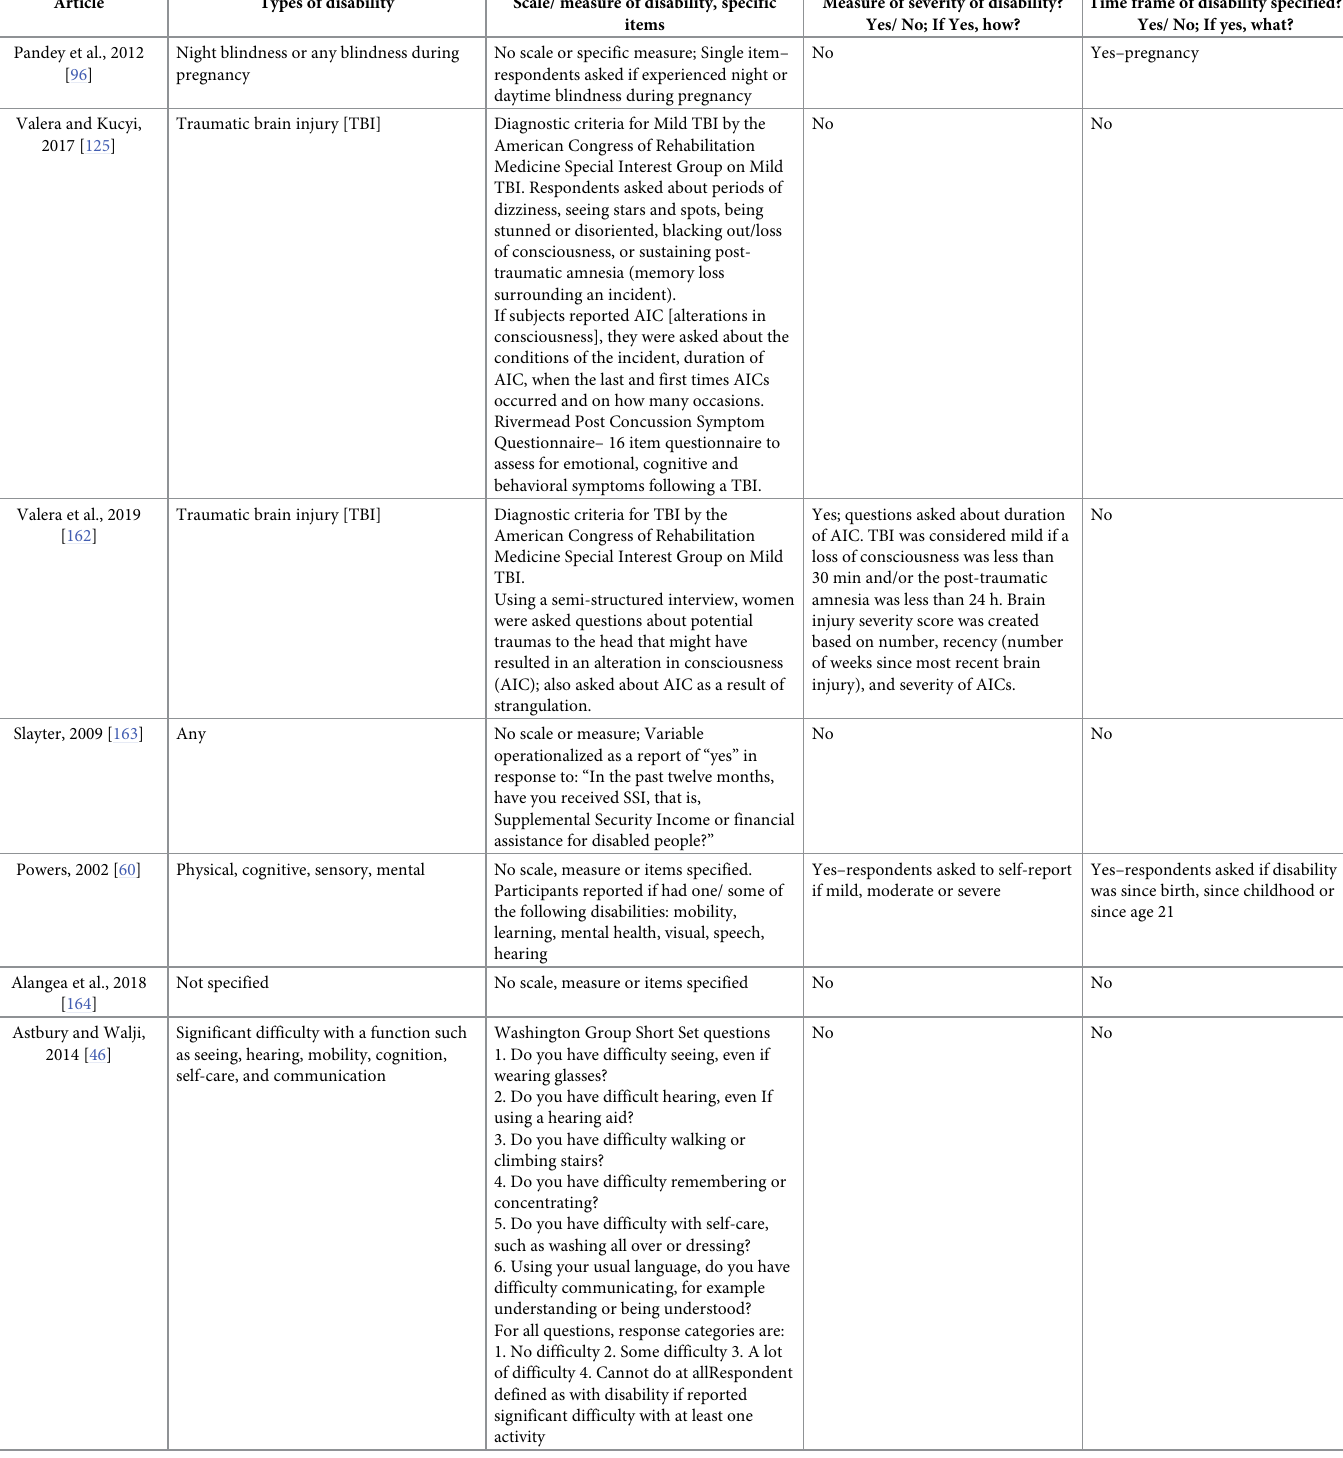
Table 4. Measurement of